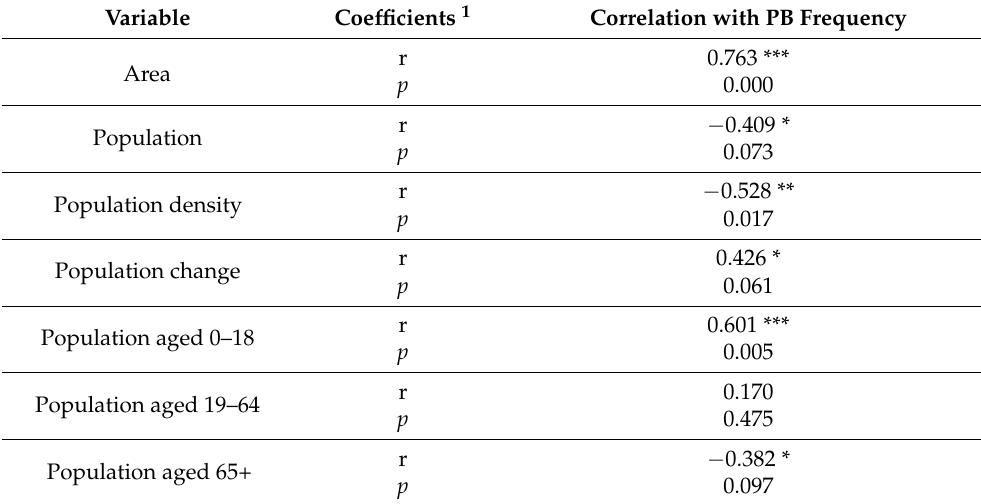
Table 1. The table of correlations between analysed factors and PB voting activity (PB frequency), in Cz˛estochowa